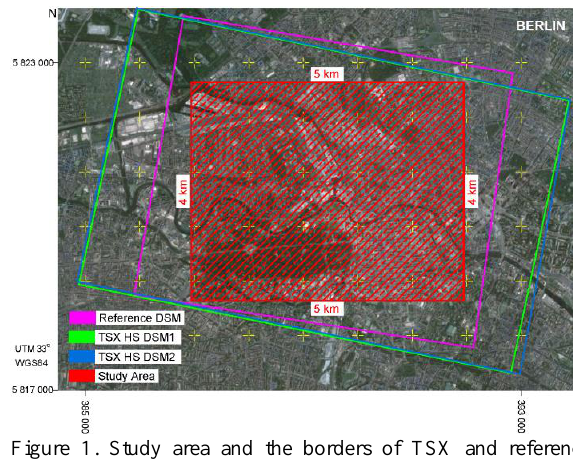
Figure 1. Study area and the borders of TSX and reference DSMs